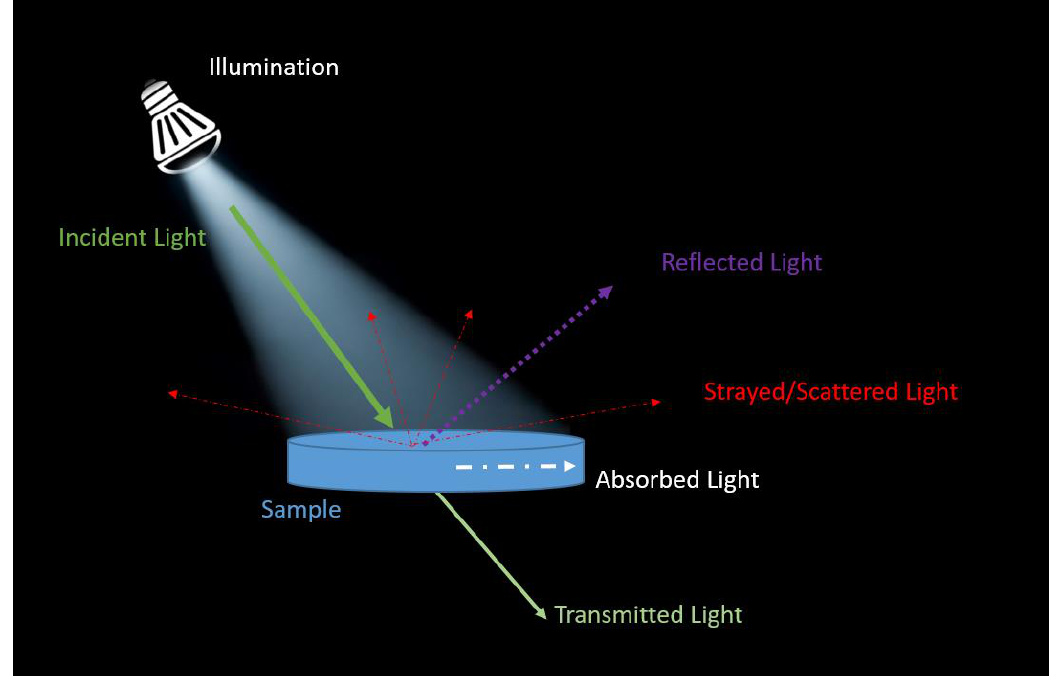
Figure 2. Different types of effects that can occur when the object is illuminated. Figure 2. Di ff erent types of e ff ects that can occur when the object is